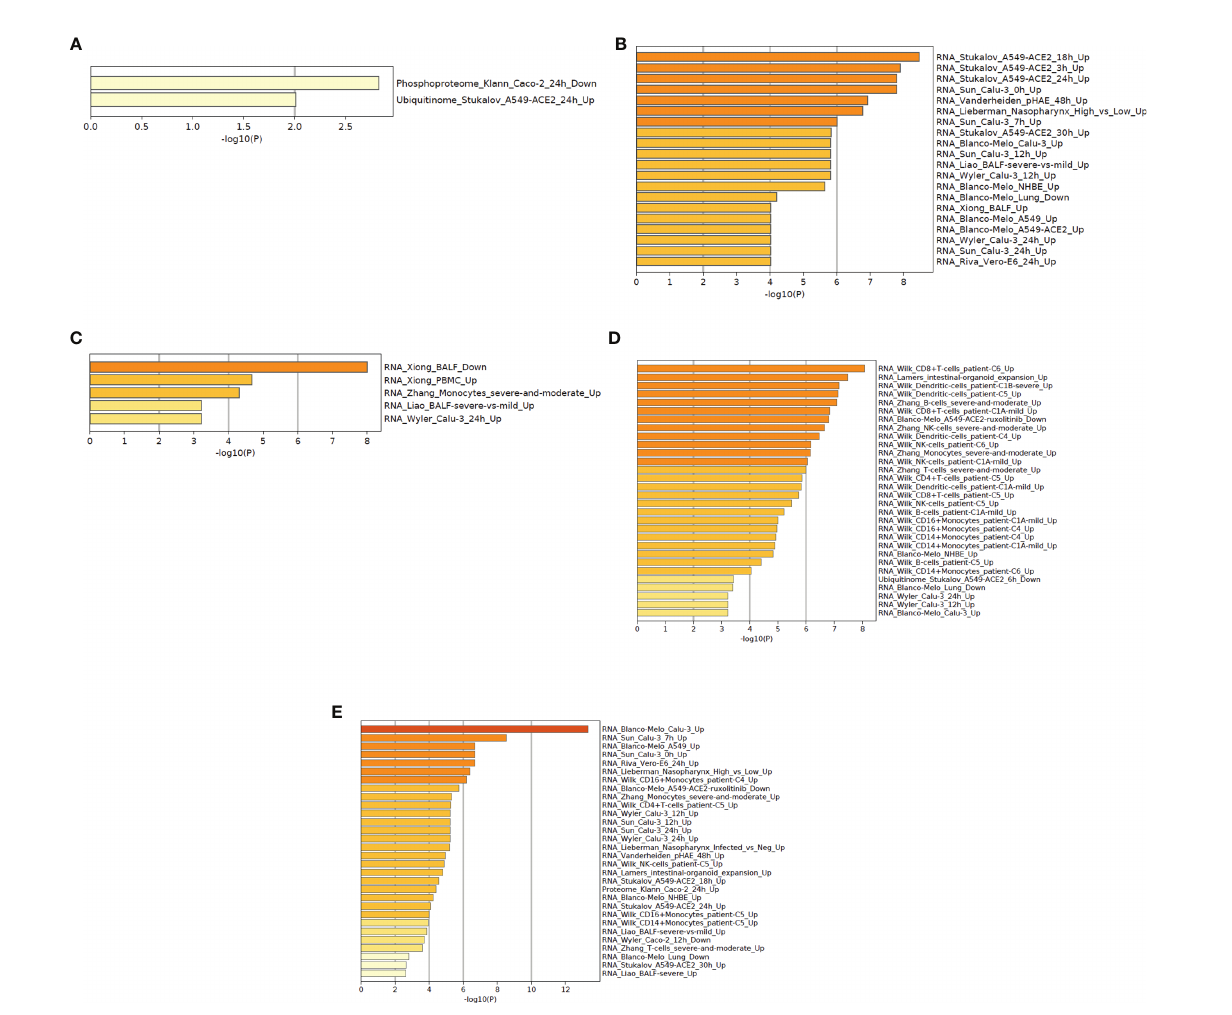
FIGURE 9 | The functional pathway enrichment analysis in COVID categories using protein-coding DEGs from our study and other studies. (A) Functional pathway enrichment analysis in COVID-19 categories from the 250 DEGs of our study. (B) Functional pathway enrichment analysis in COVID-19 categories with the top- ranked genes of the Xiong et al. study that used bronchoalveolar lavage fl uid sample. (C) Functional pathway enrichment analysis in COVID-19 categories with the top-ranked genes of the Xiong et al. study that used PBMC samples. (D) Functional pathway enrichment analysis in COVID-19 types with the Ziegler et al. study. (E) Functional pathway enrichment analysis in COVID-19 categories with the Jain et al.